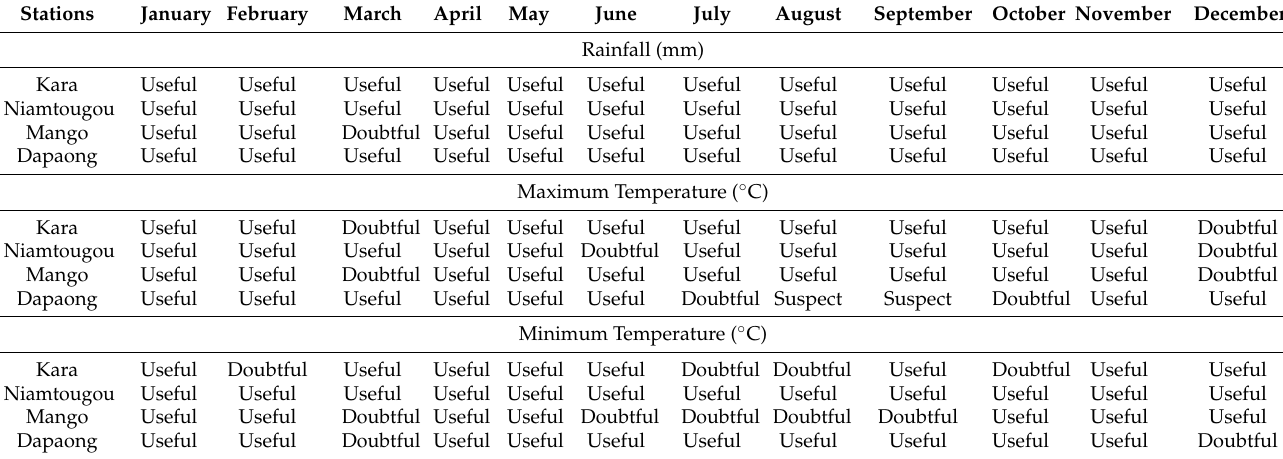
Table 3. Summary of homogeneity results of the monthly rainfall (mm) and temperature data ( ◦